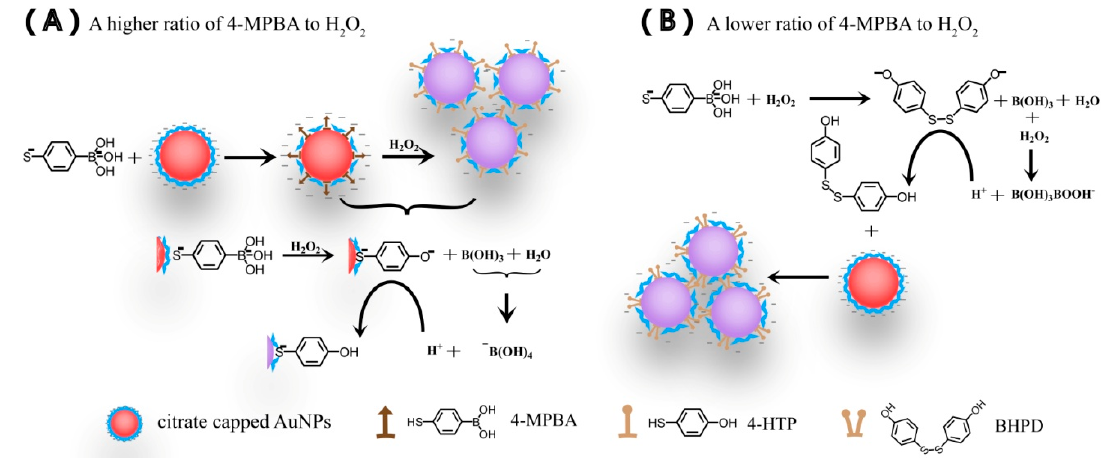
Figure 11. The proposed possible mechanisms for the aggregation of citrate ‐ capped AuNPs. ( A ) Mixture ((AuNPs+4 ‐ MPBA)+H 2 O 2 ) with a higher ratio of 4 ‐ MPBA to H 2 O 2 ; ( B ) mixture ((4 ‐ MPBA+H 2 O 2 )+AuNPs) with a lower ratio of 4 ‐ MPBA to H 2 O 2 .